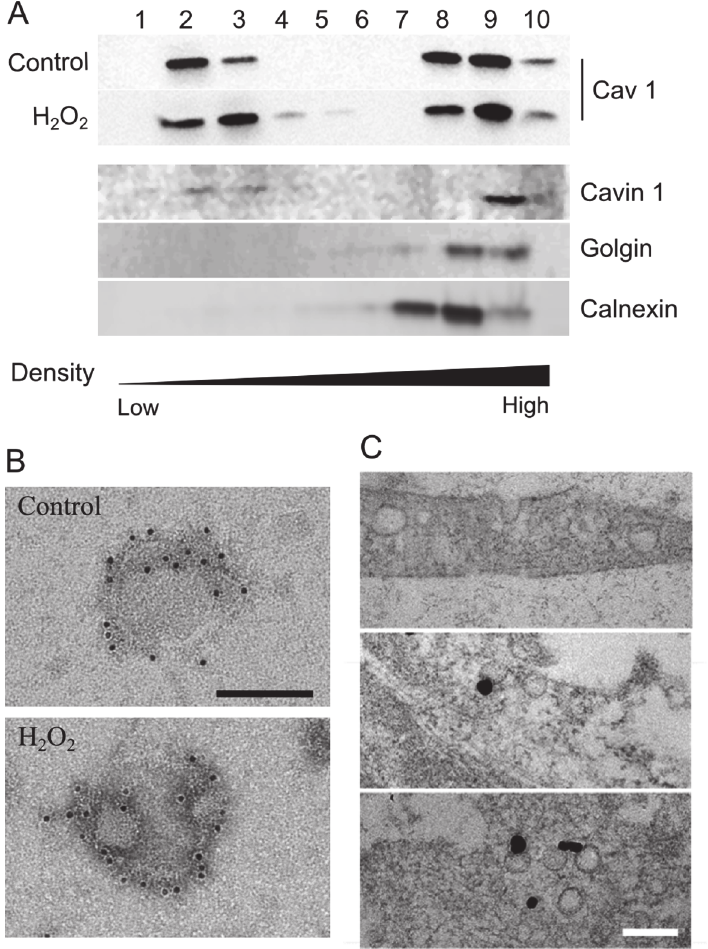
Fig 3. Effect of H 2 O 2 on caveolae isolated through flotation gradient and identification of caveolae in C 2 C 12 myoblasts. Myoblasts were incubated one hour with 500 μ M H 2 O 2 . Cell extracts were fractionated by flotation trough a discontinuous sucrose gradient as described in materials and methods. Western blotting of fractions 1 to 10 was carried out with anti-caveolin 1 antibodies. Cavin 1, Golgin and Calnexin were immunoblotted to identify caveolae, golgi and RE specific fractions (A). Fraction 2 isolated from the flotation gradient was processed for immune electron microscopy using anti-caveolin 1 primary antibodies and 10 nm gold-conjugated protein A (B). Myoblasts were processed for (immune) electron microscopy as described in materials and methods. Representative electron micrographs show the morphology of caveolae (top panel) and caveolin 1 enriched “ open ” vesicular structures at the plasma membrane (middle) or “ closed ” in the cytosol (bottom panel) (C). Scale bar = 100